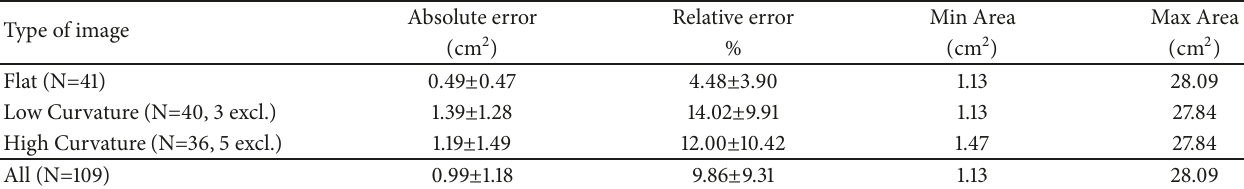
Low Curvature (N=40, 3 excl.)